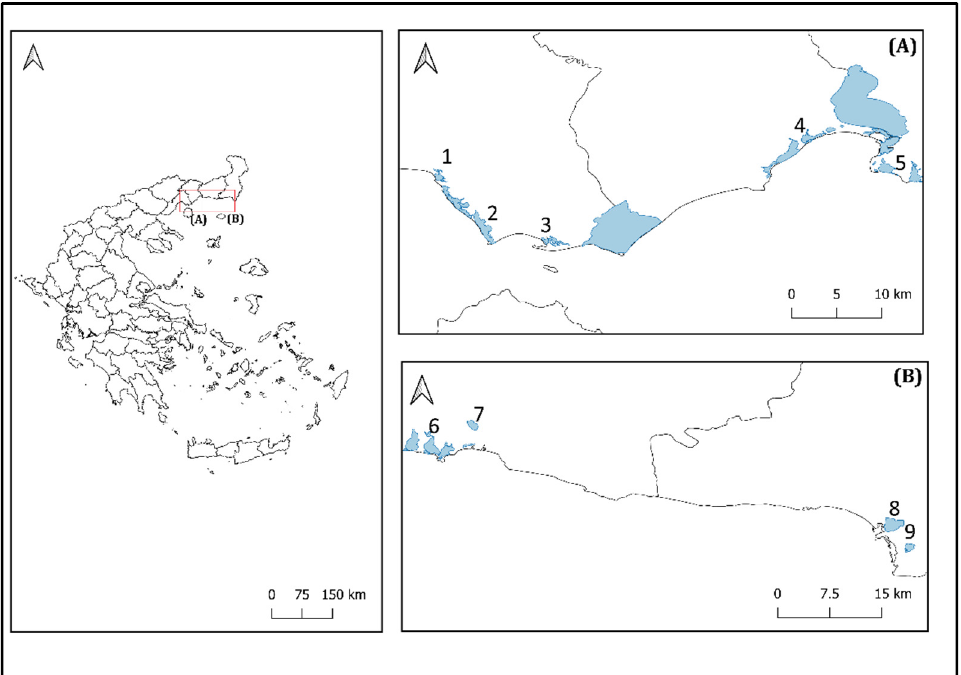
Figure 1. Map of the East Macedonia and Thrace Region (A, B), where the studied lagoons are situated (1 = Vassova L., 2 = Agiasma L., 3 = Keramoti L., 4 = Lafri L., 5 =Fanari/Xirolimni, 6 = Ptelea L., 7 = Ismarida system, 8 = Drana L., 9 = Monolimni L.).